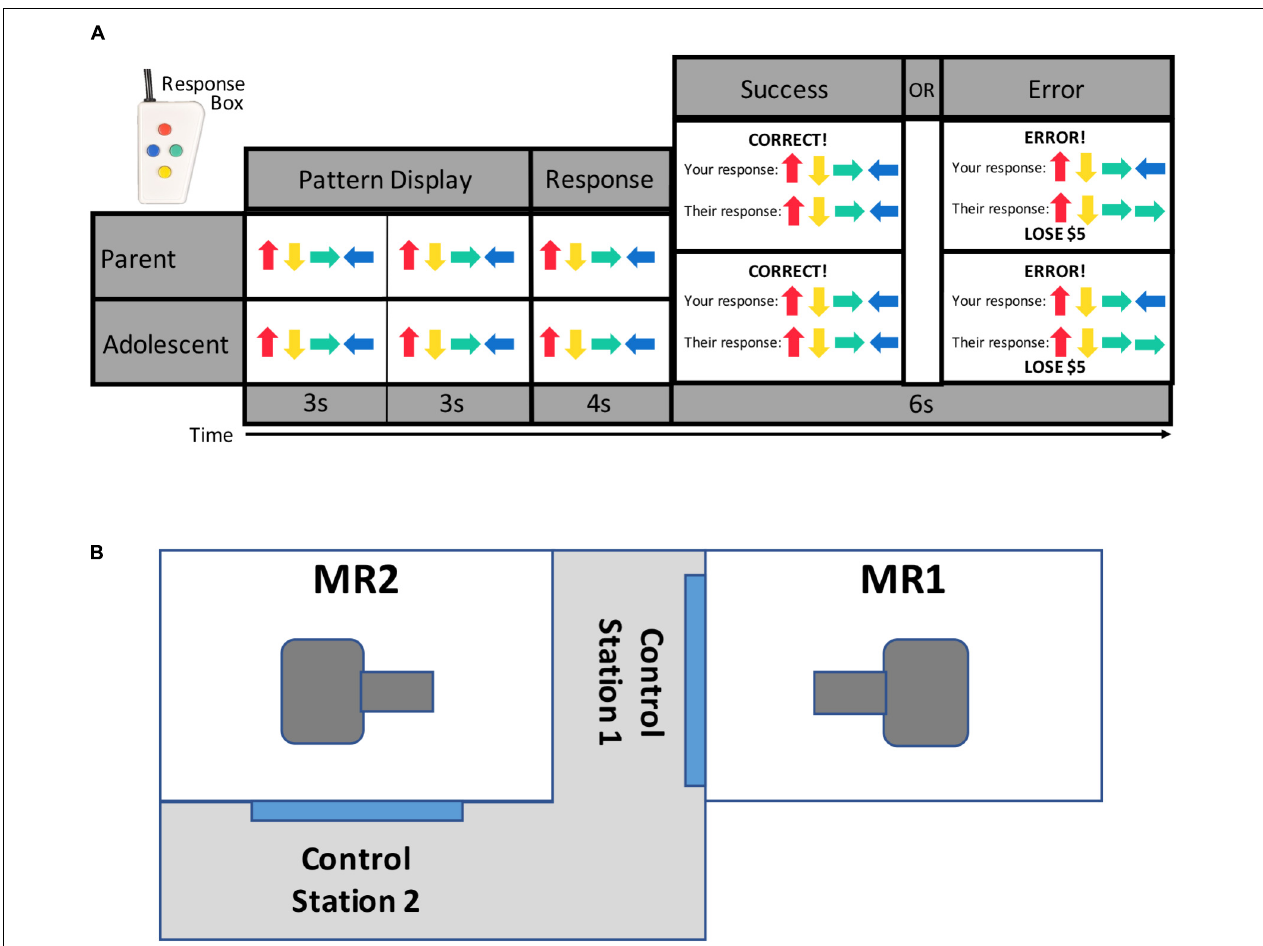
FIGURE 1 | TEAM task design and scanner configuration. Parents and adolescents were scanned simultaneously while each performing the TEAM task (A) . The TEAM task consists of trials during which a pattern of four arrows is displayed twice to the participant, and the participant then enters the pattern from memory using a handheld response box. Participants are then provided feedback about both their own and their partner’s performance. Unbeknownst to the participant, however, the feedback for their partner’s performance has been pre-programmed to either show a correct (14 trials per run) or incorrect (three trials per run) response. Scanners are located in close physical proximity separated by a shared control room (B)